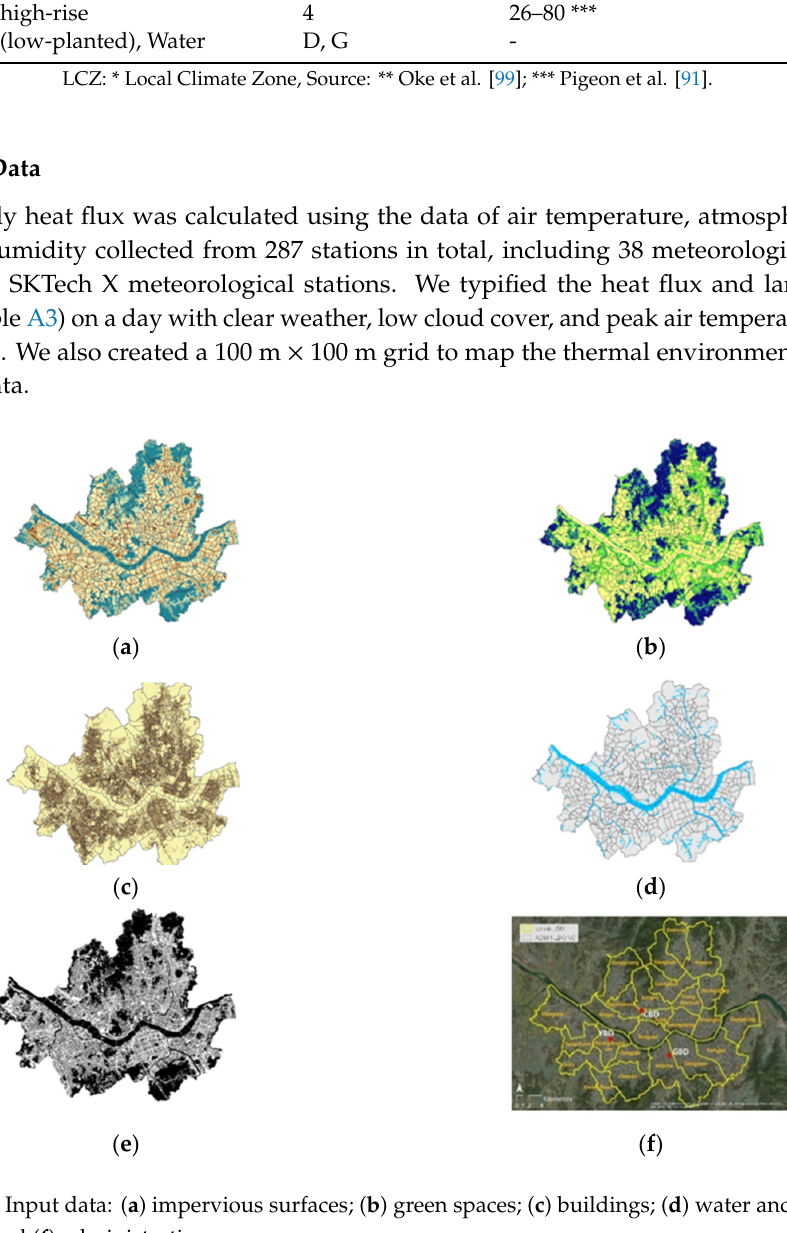
Figure A1. Input data: ( a ) impervious surfaces; ( b ) green spaces; ( c ) buildings; ( d ) water and wetlands; ( e ) roads; and ( f ) administrative map.